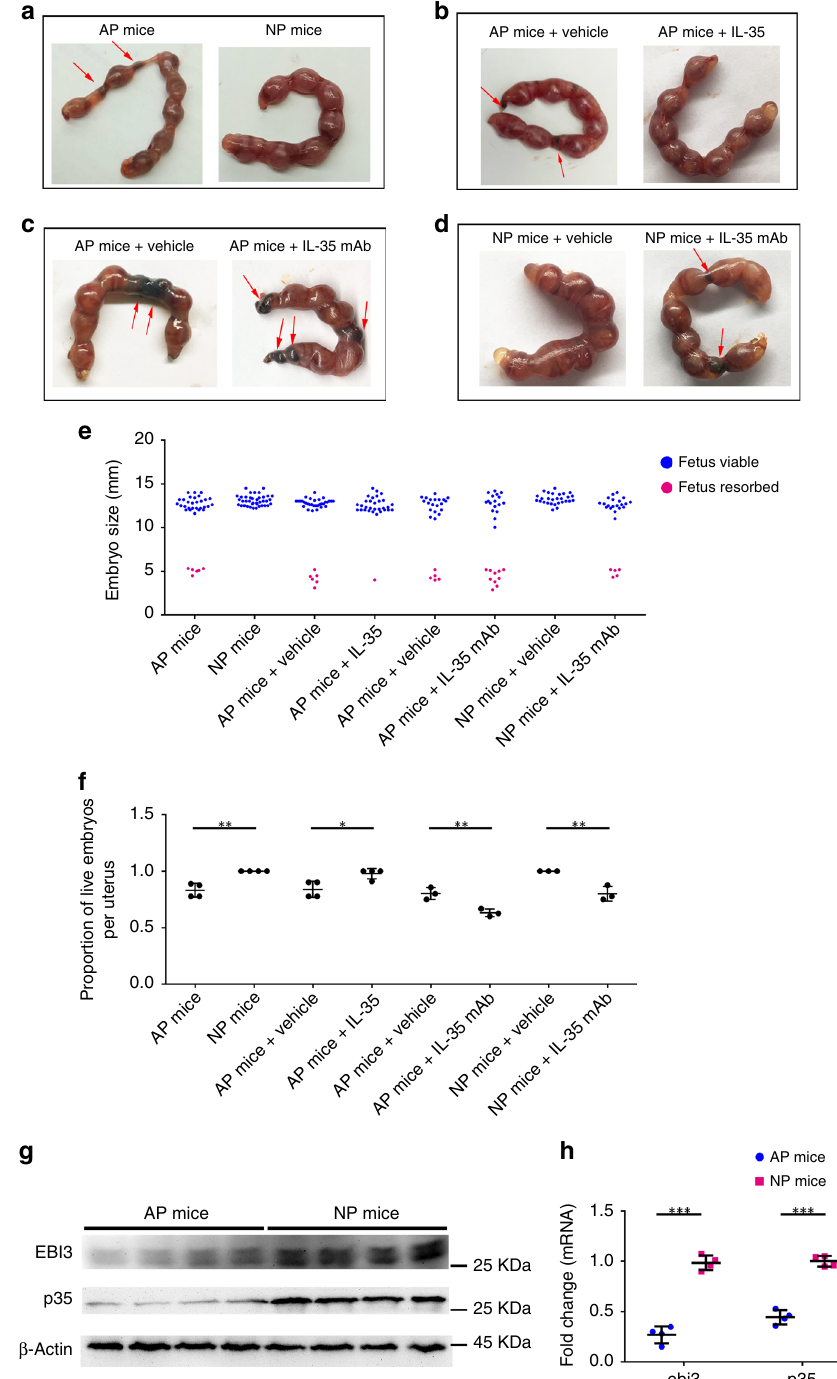
Fig. 5 Phenotype of fetuses from NP mice and AP mice and the expression of IL-35 in the placenta. Pregnant CBA/J female mice were euthanized on Day 13.5 of pregnancy. a – d Representative pictures showing the embryos and live fetuses per uterus from different treated AP and NP mice. Red arrows: aborted embryos. e Embryos size were measured. From left to right: n = 35 embryos from four separate mothers (AP mice), n = 39 embryos from four separate mothers (NP mice), n = 38 embryos from four separate mothers (AP mice + vehicle), n = 31 embryos from four separate mothers (AP mice + IL- 35), n = 25 embryos from three separate mothers (AP mice + vehicle), n = 27 embryos from three separate mothers (AP mice + IL-35 mAb), n = 28 embryos from three separate mothers (NP mice + vehicle) and n = 25 embryos from three separate mothers (NP mice + IL-35 mAb). f Proportion of live embryos per uterus was calculated with following formula: Proportion of live embryos per uterus = (Number of live embryos per uterus)/(Number of total embryos per uterus). g – h Pregnant CBA/J female mice were euthanized on Day 13.5 of pregnancy and the placenta was isolated and teased apart. Then the protein and mRNA were extracted from the tissue. The protein levels of EBI3 and p35 in placenta were determined by western blot ( n = 4) ( g ). Quantitative real-time RT-PCR analysis was applied to compare the expression of ebi3 and p35 in the placenta of NP and AP females ( n = 4) ( h ). Data were represented as mean ± SD. Signi fi cance was determined by Student ’ s t -test. * P < 0.05, ** P < 0.01, and *** P <